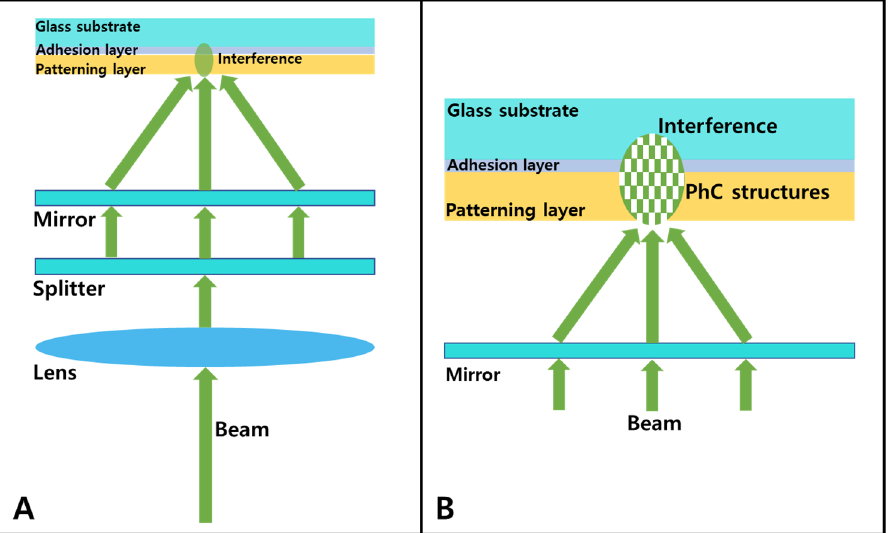
Figure 1. A schematic image of the IL setup ( A ) and interference at the substrate for fabricating PhC structures ( B ).